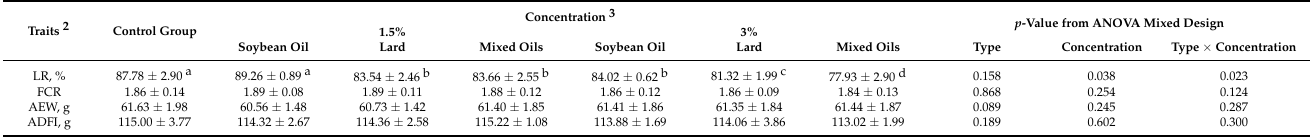
Table 3. Effects of different concentrations of soybean oil, lard, and mixed oils on the production performance of laying hens 1 .